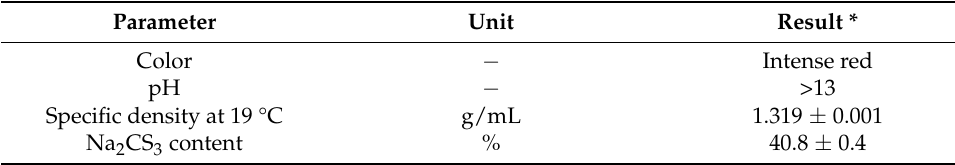
Table 2. Determined physicochemical parameters of Na 2 CS 3